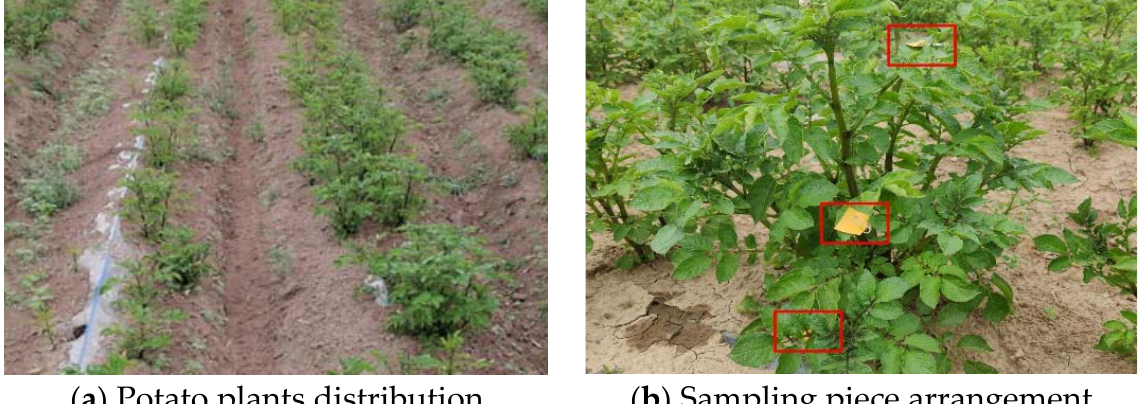
Figure 11. Targeted and variable spray experiment.